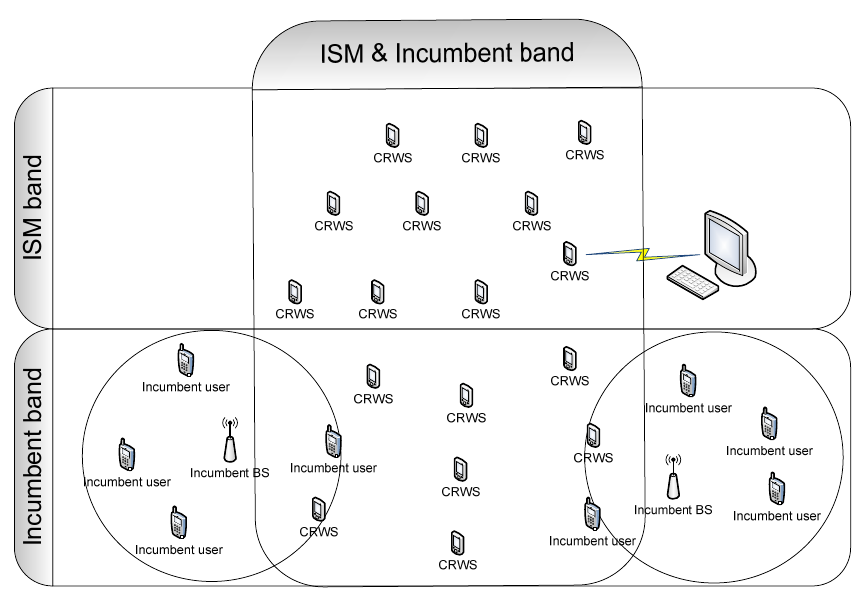
Figure 2. CR-WSNs